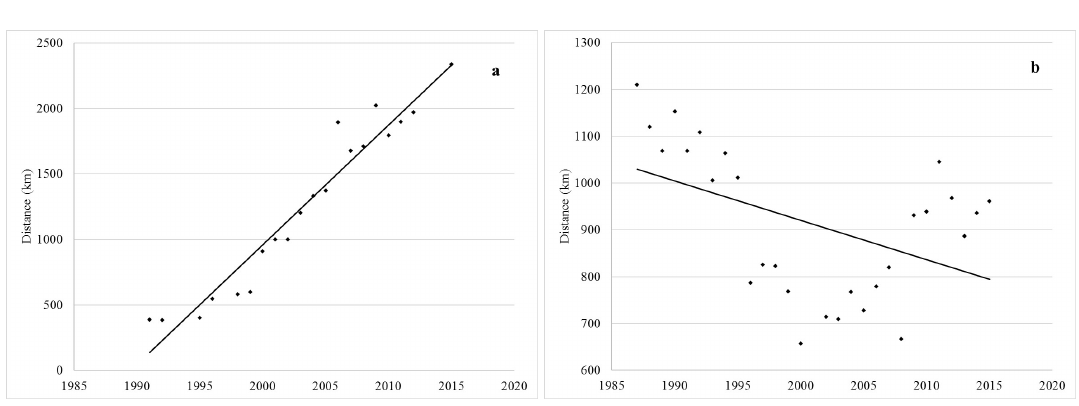
Figure 6. Moving decadal means of the distance from LMI to landfall of the strongest TCs in the ( a ) North Atlantic and ( b ) West Pacific basins. The significant linear trends are shown with a solid